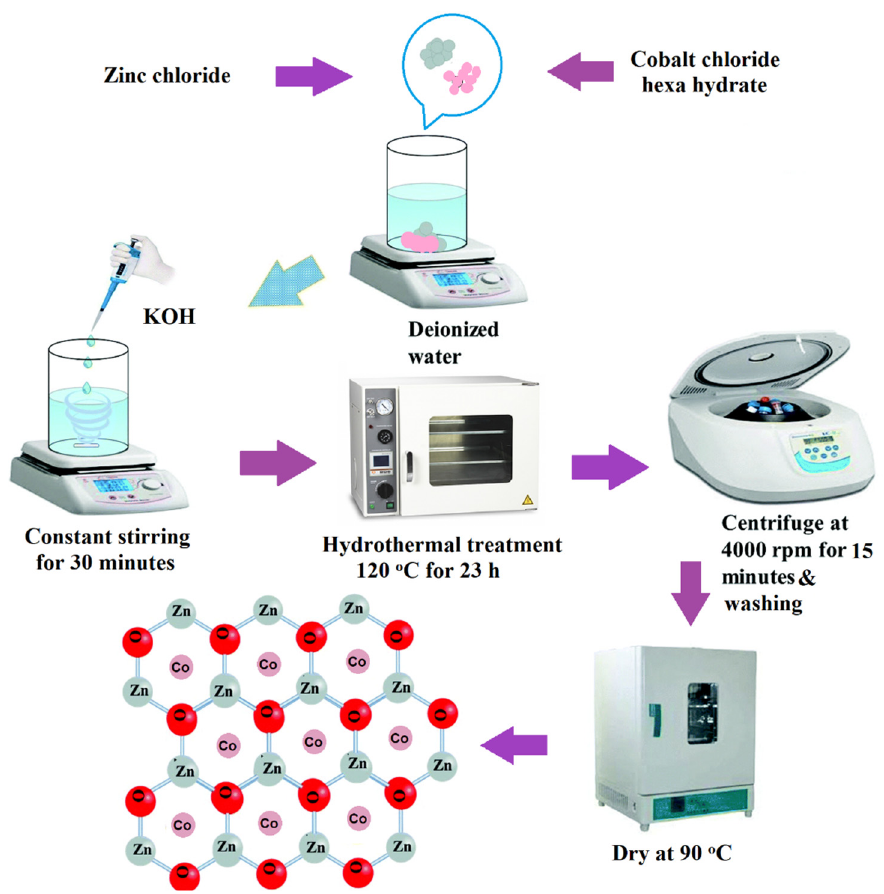
Figure 1. Schematic representation for the experimental setup.